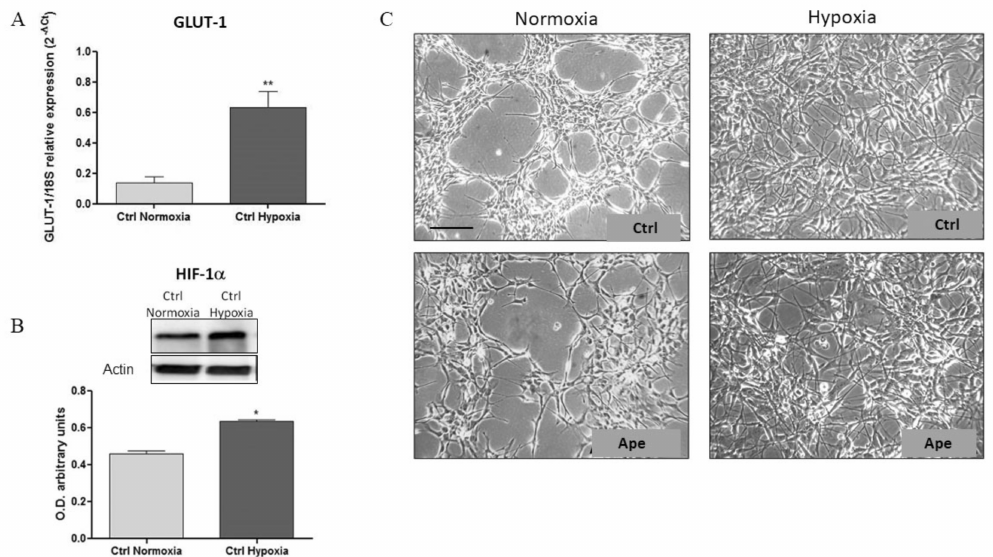
Figure 1. ( A ) Real-Time PCR analysis of GLUT-1 transcript expression, in GB7 cells in normoxia and after 24 h hypoxia. The data are the mean ± SEM of the three independent experiments performed in duplicate ( t -test: ** p < 0.01). ( B ) Western blotting analysis of the Hypoxia-inducible-factor (HIF-1 α ) protein in GB7 cells in normoxia and 24 h hypoxia. The graph below shows the densitometric analysis of the bands obtained after normalization with the β -actin as housekeeping reference protein ( t -test; * p < 0.05). The data are the mean ± SEM of the three independent experiments. ( C ). GB7 cells in normoxia and hypoxia. After 24 h of 100 µ M arecaidine propargyl ester (Ape) treatment the cells present a more dispersed organization, more evident in hypoxia (scale bar = 150 µ